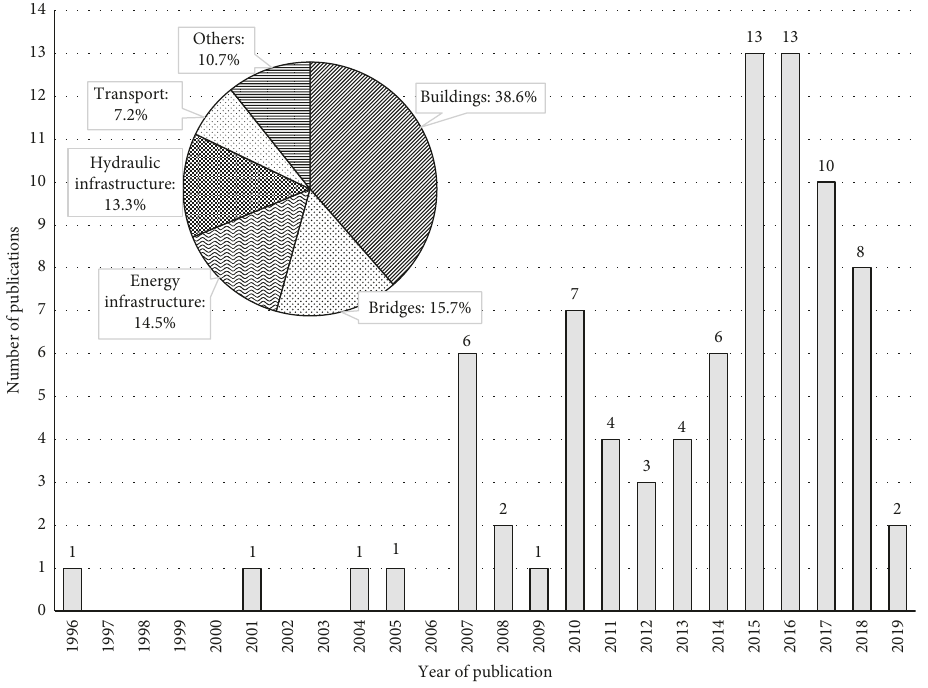
Figure 2: Distribution of contributions per year